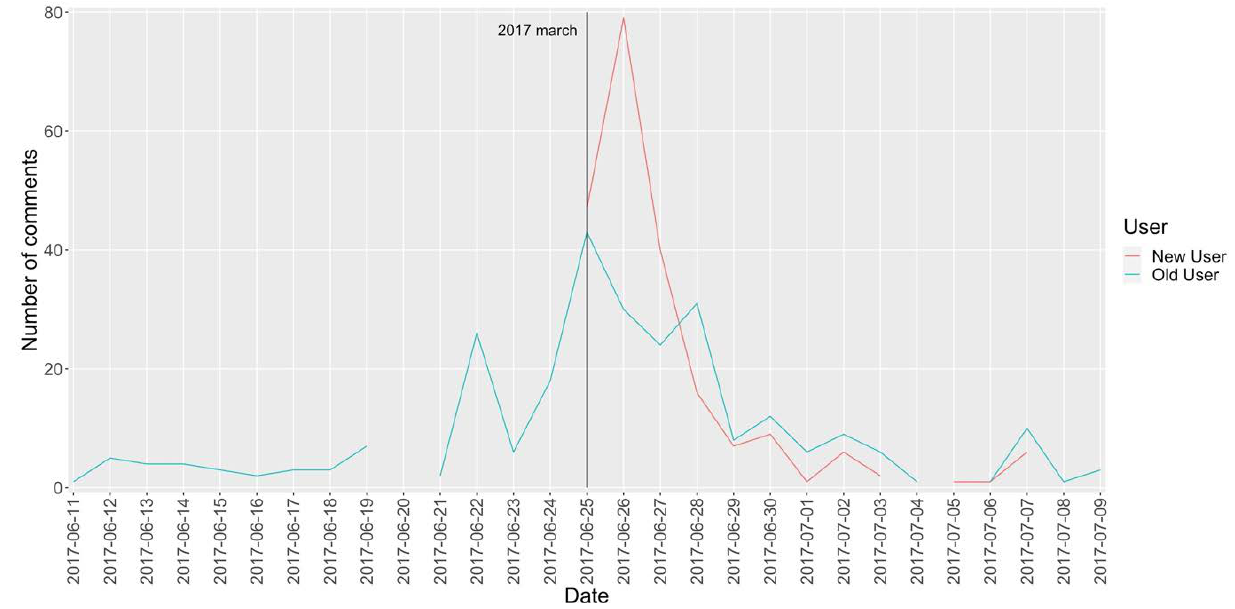
Figure 3. Number of comments made by old and new users in the two weeks before and after the 2017 march.